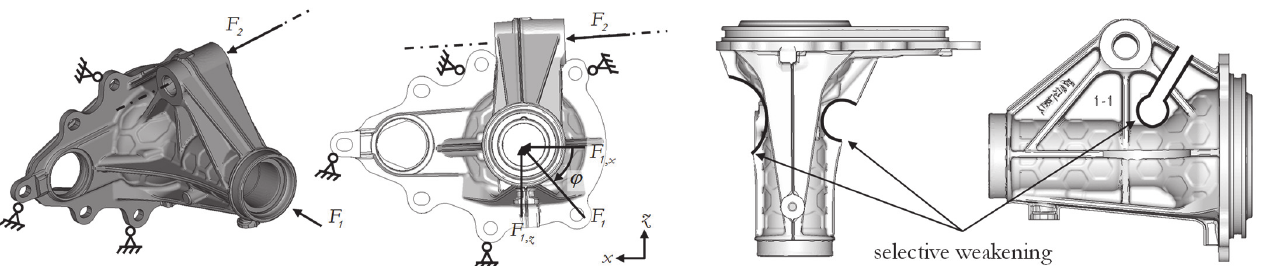
Figure 3: Housing of a rear axle steering subjected to two load channels (left) and selective weakening of the component (right). Identification of the critical location x